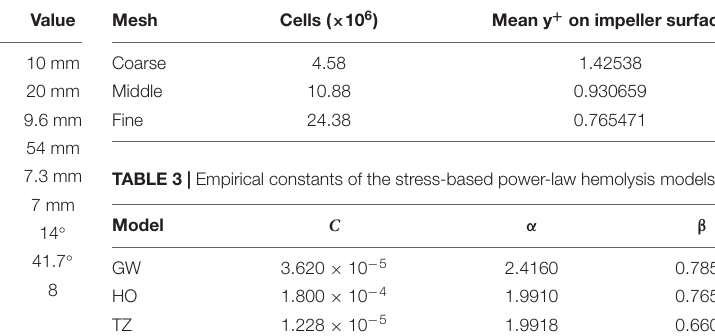
TABLE 2 | Details of mesh for grid sensitivity analysis.